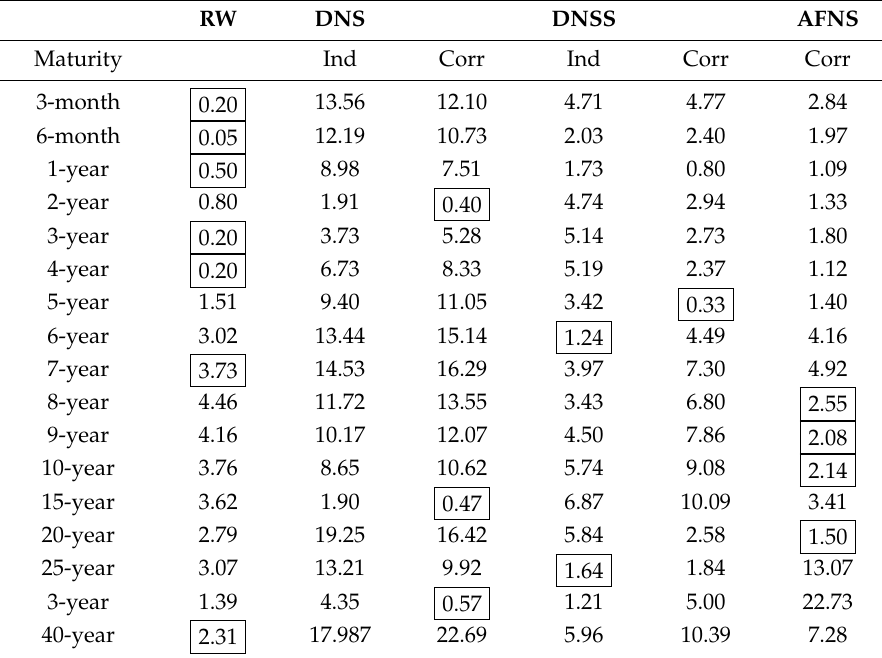
Table 4. Root mean squared forecast error of a 1-month forecast.